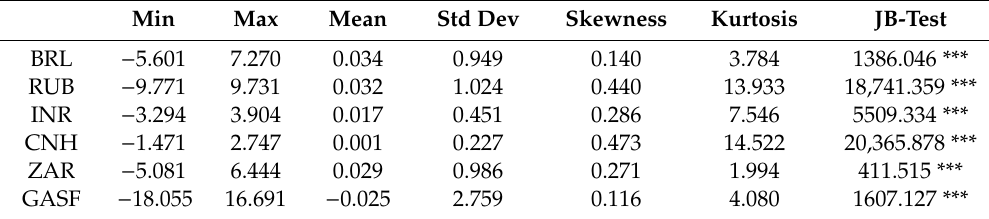
Table 2. Summary statistics for daily